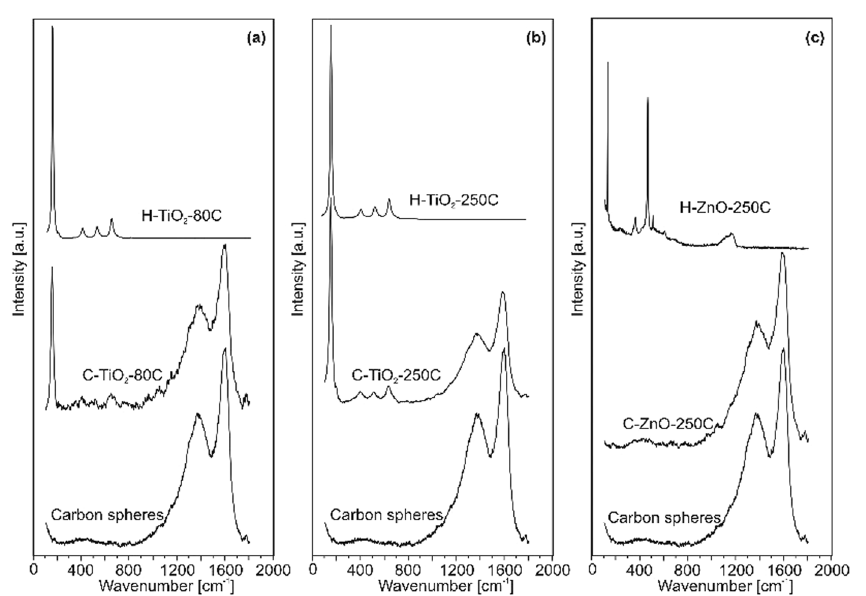
Figure 3. Raman spectra of the samples. The spectra of the bare CNSs, the composite and the hollow nanospheres are shown with ( a ) TiO 2 deposited at 80 °C, ( b ) TiO 2 deposited at 250 °C and ( c ) ZnO deposited at 250